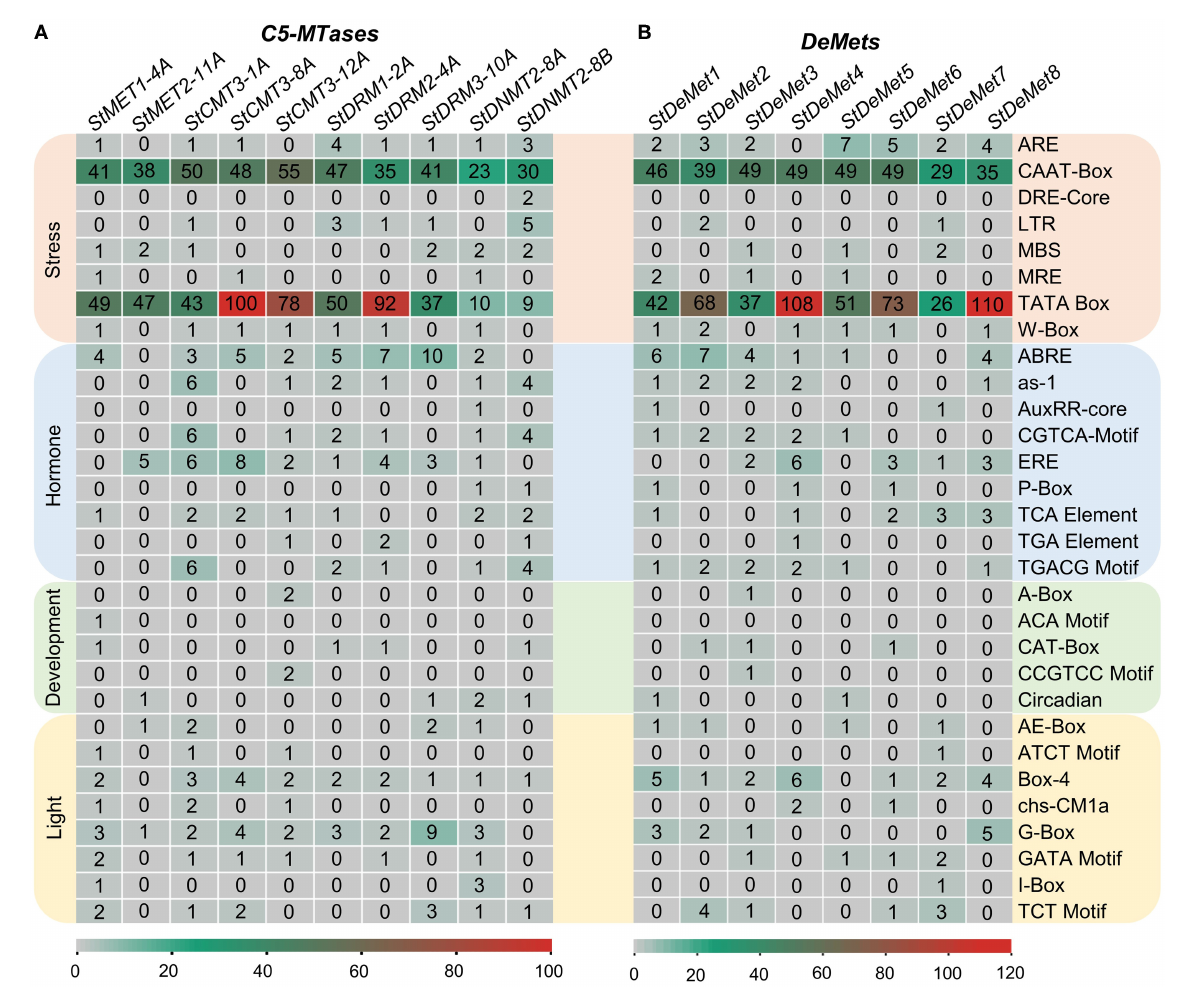
FIGURE3 Cis-acting regulatory elements in the promoters of (A) StC5-MTase and (B) StDeMets . Cis-regulatory elements are classified into four categories (light, development, hormones and stress responses). The numbers in the heat map depict the abundance of cis-regulatory elements in the promoter